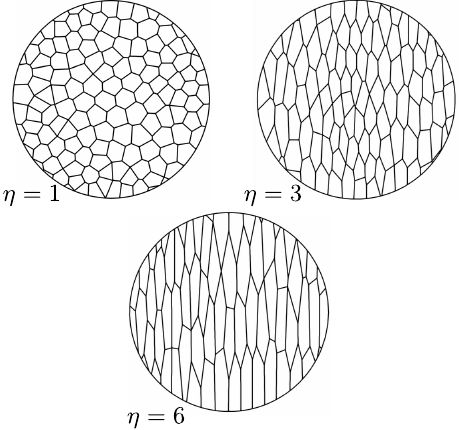
Figure 1. Screenshots of samples presenting a di ↵ erent cell as- pect ratio ⌘ .